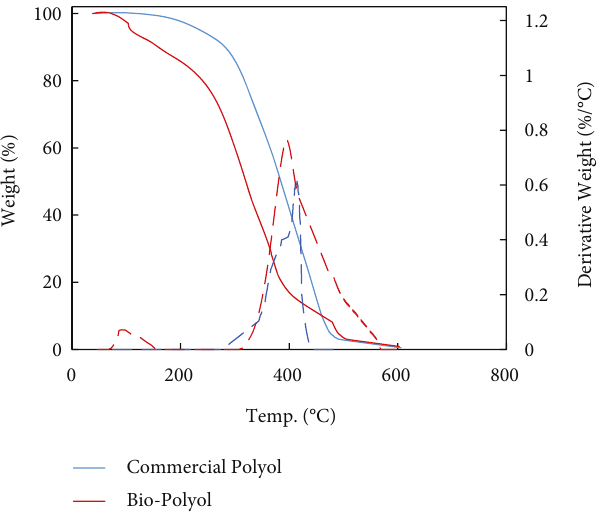
Figure 12: TGA-DTG of commercial and synthesized polyols.